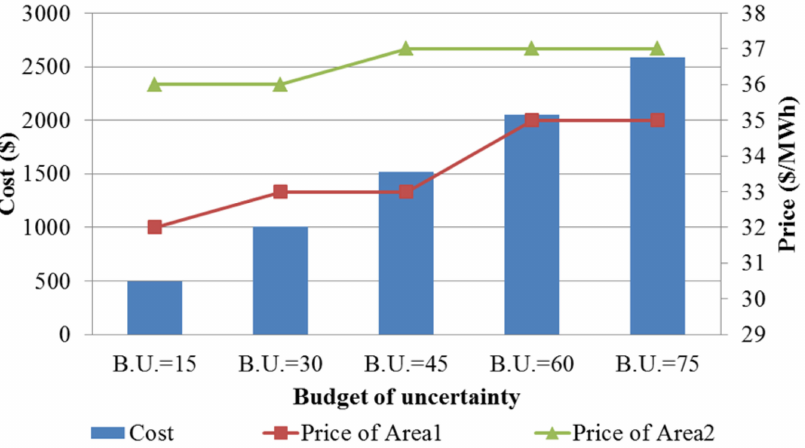
Figure 6. Impact of budget of uncertainty (MW) on balancing cost and